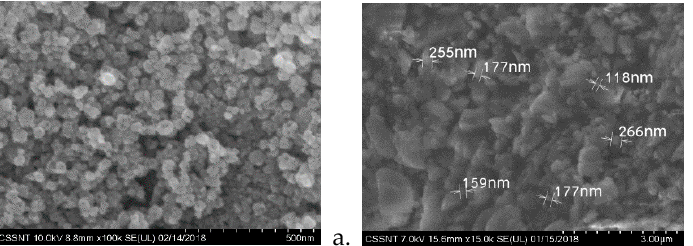
Figure 2. ( a ) SEM images of TiO 2 powder; ( b ) particle measurements for 3D-printed denture sample.